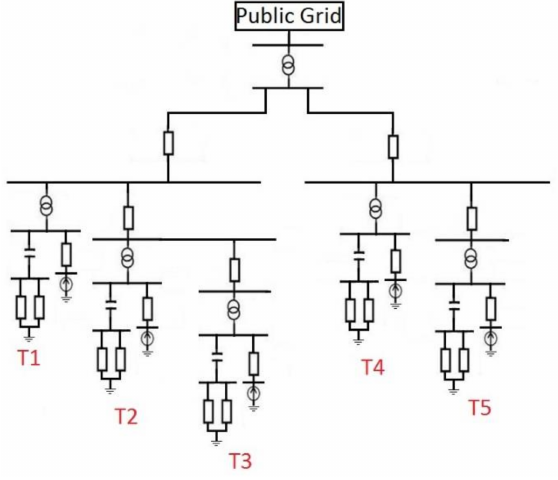
Figure A1. Impedance model for the 5-turbine wind power plant, with T1 through T5 indicating the five turbines.